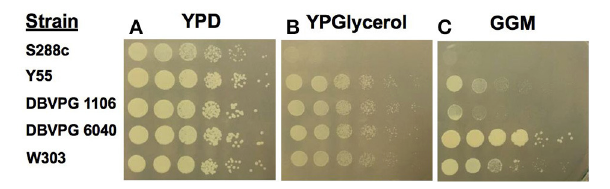
FIGURE 1 | [ GAR + ] prion induction by wine strains. Growth of the evaluated yeast strains on the control media, YPD (YP media with 2% glucose) (A) . Growth of yeast strains on basal YP media with 2% glycerol (B) . Growth on prion selective GGM medium (C) .